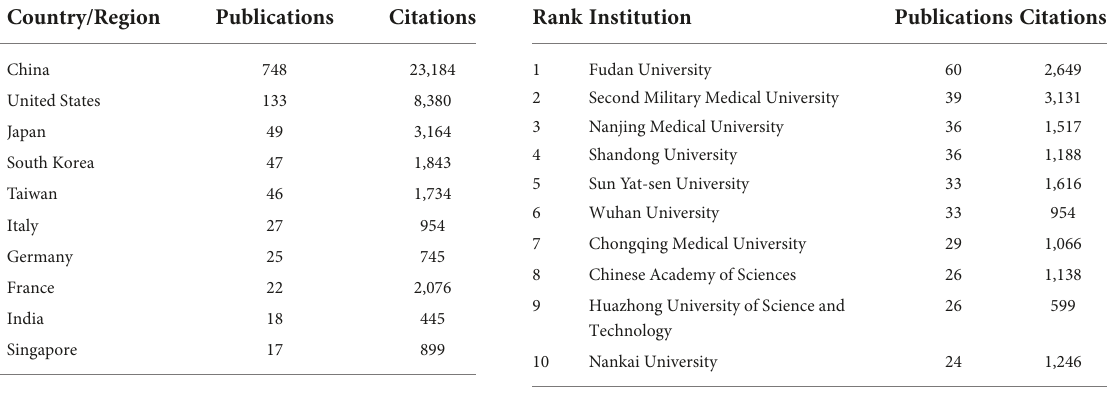
TABLE 3 The top 10 productive countries/regions. TABLE 4 The top 10 productive